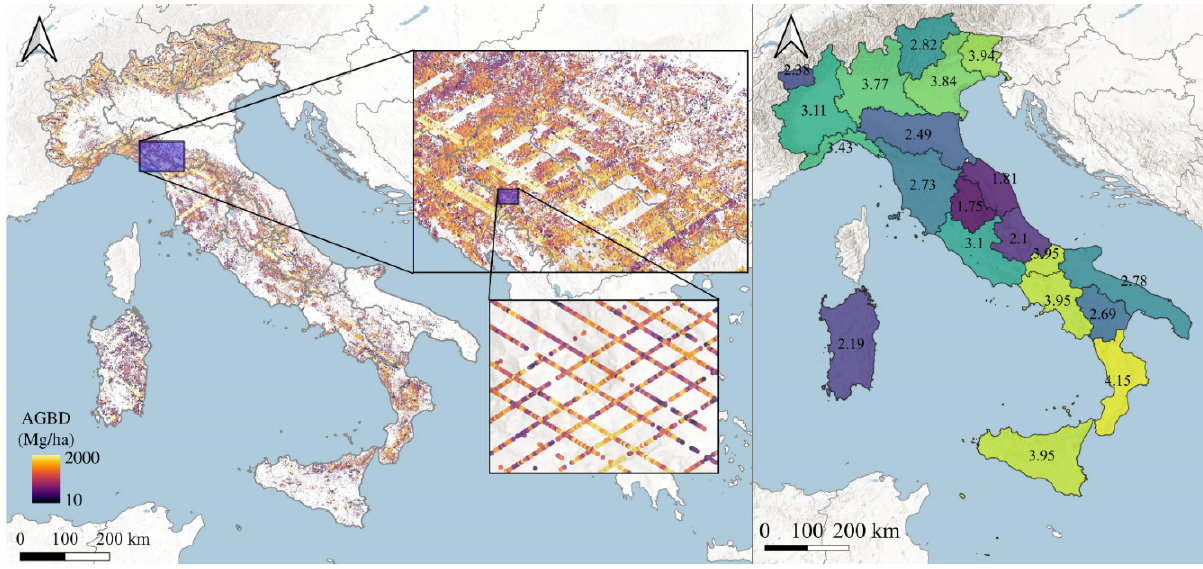
Figure 2. AGBD of GEDI pulses acquired over Italian forests. On the right is the percentage of GEDI coverage to the forest area by NUTS 2 unit.